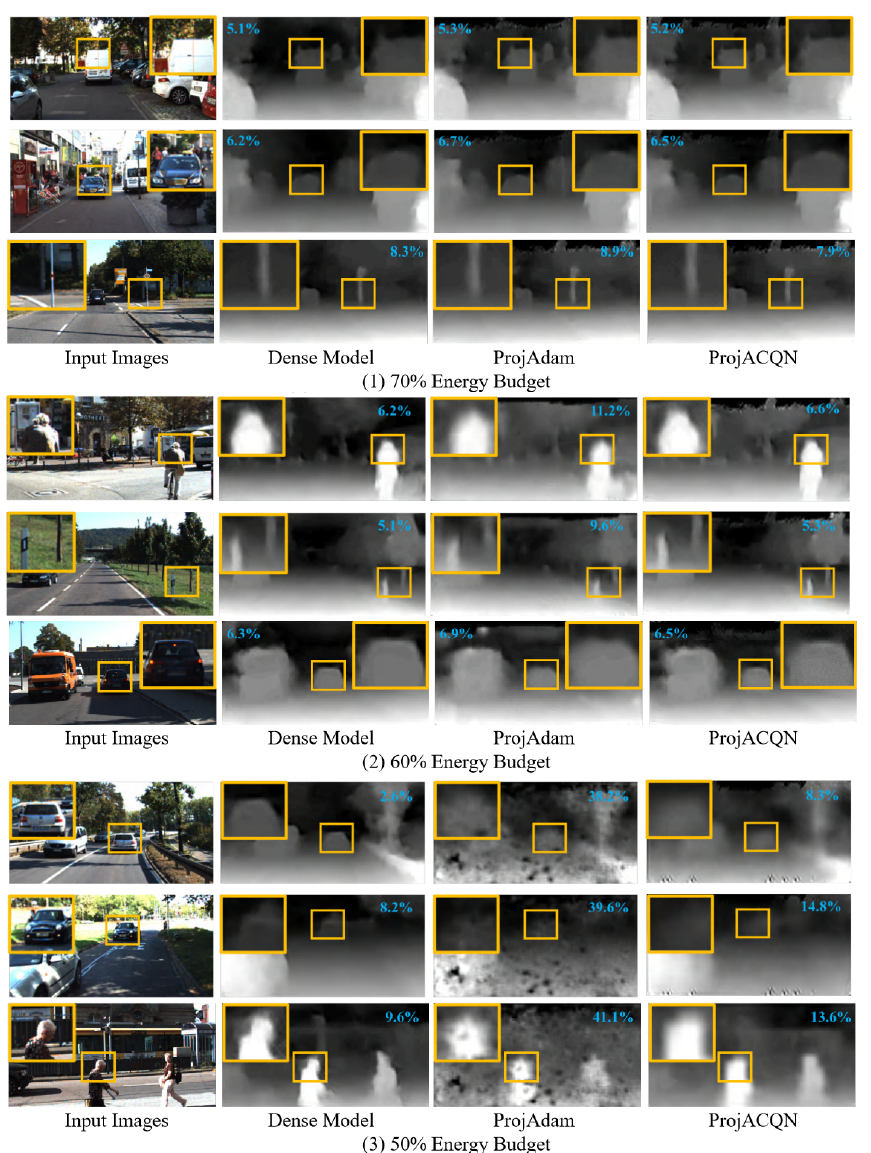
Figure 5. Disparity predictions from stage four of AnyNet under 50%, 60% and 70% energy budgets on KITTI-2015. The percentages in the figure represent the three-pixel errors, the lower the better. Evaluation results of ProjACQN are marked in blue. Table 5. Three-pixel error (%) of AnyNet with 50%, 60% and 70% energy budget on KITTI-2015 datases using AGV. A lower three-pixel error is